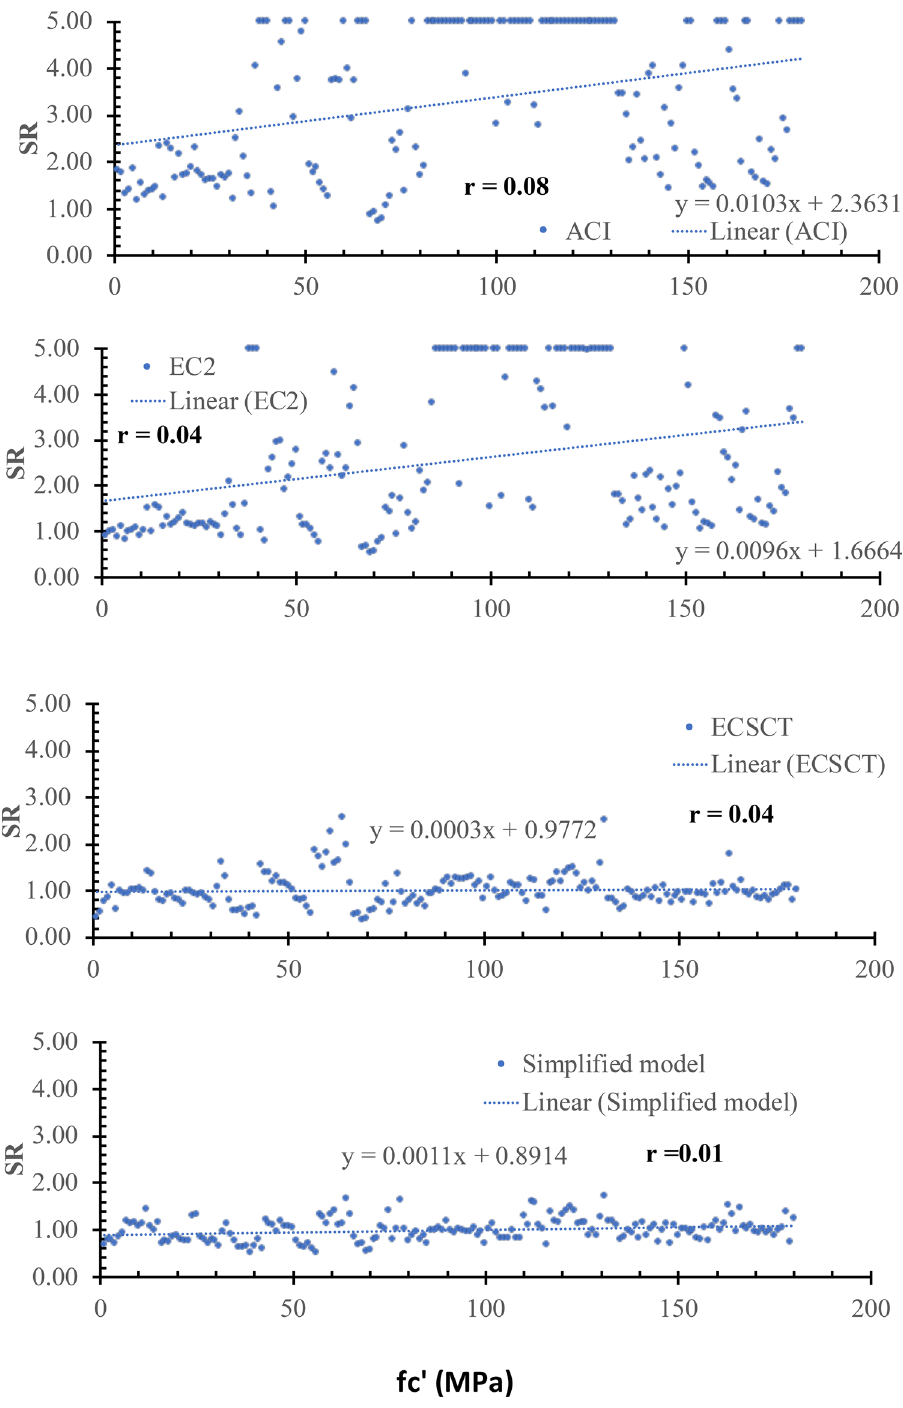
Figure 14. SR using various methods versus the fc ′